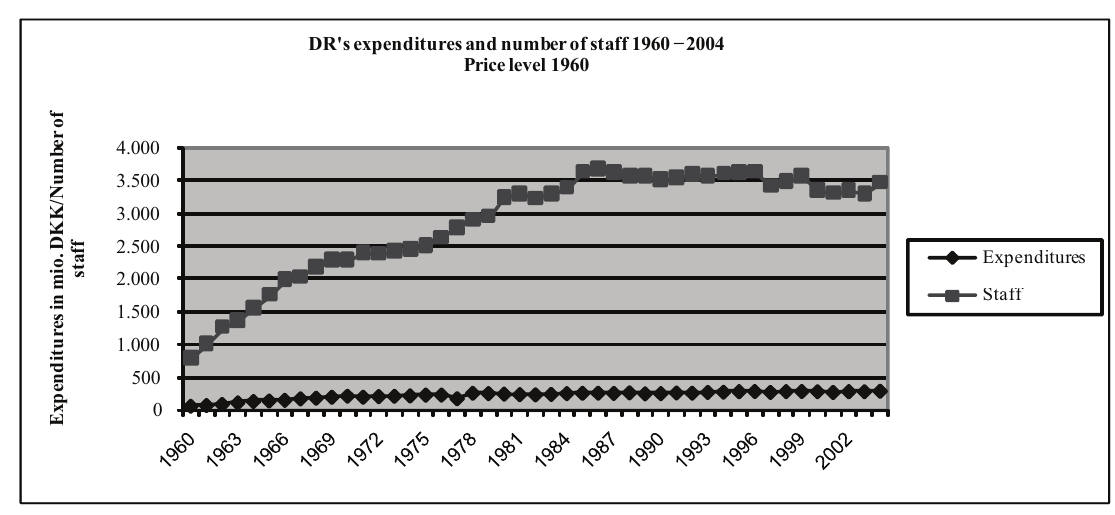
figure 2. Dr’s expenditure and staff 1960-2004 (Jensen,